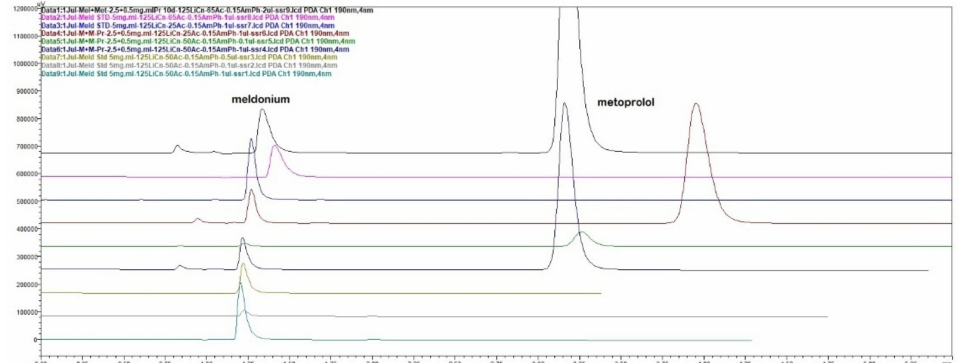
Figure 6. Retention time of meldonium and metoprolol mapping with variations of ACN percentage in composition of mobile phase with 13 mM NH 4 H 2 PO 4 with column LiChrospher CN 125 × 4 mm.